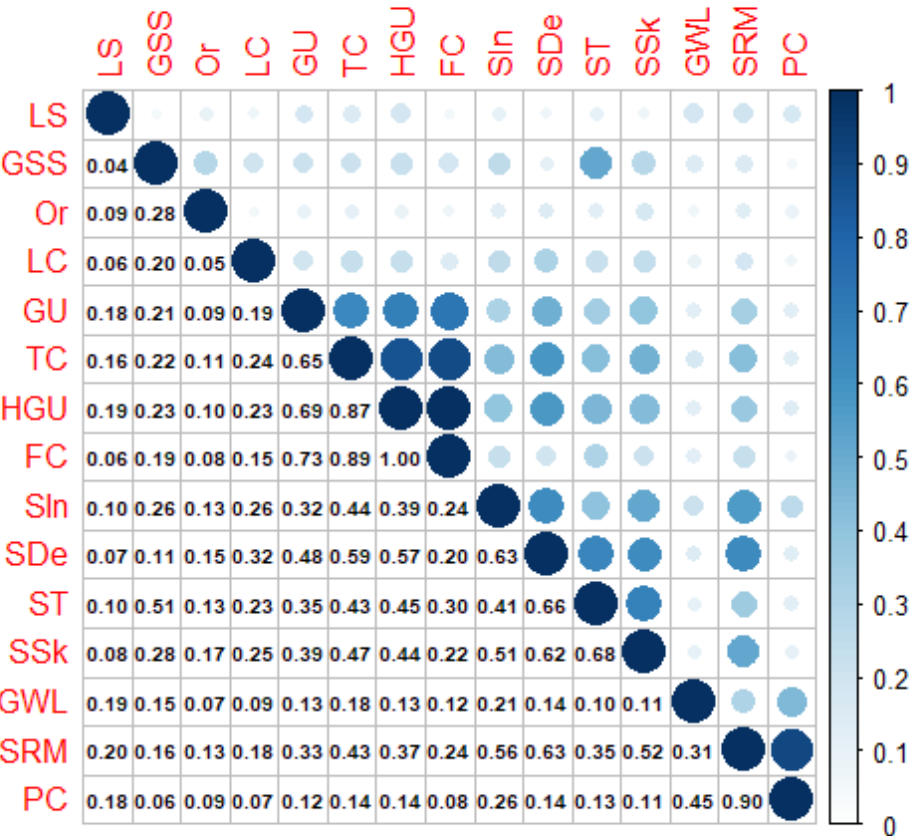
Figure 4. Matrix of Cramer’s V. Three groups of highly correlated variables are present. Group 1: GU, TC, HGU, and FC; Group 2: SIn, SDe, ST, and SSk; and Group 3: SRM and PC. The variables are ordered according to the results of the agglomerative hierarchical clustering